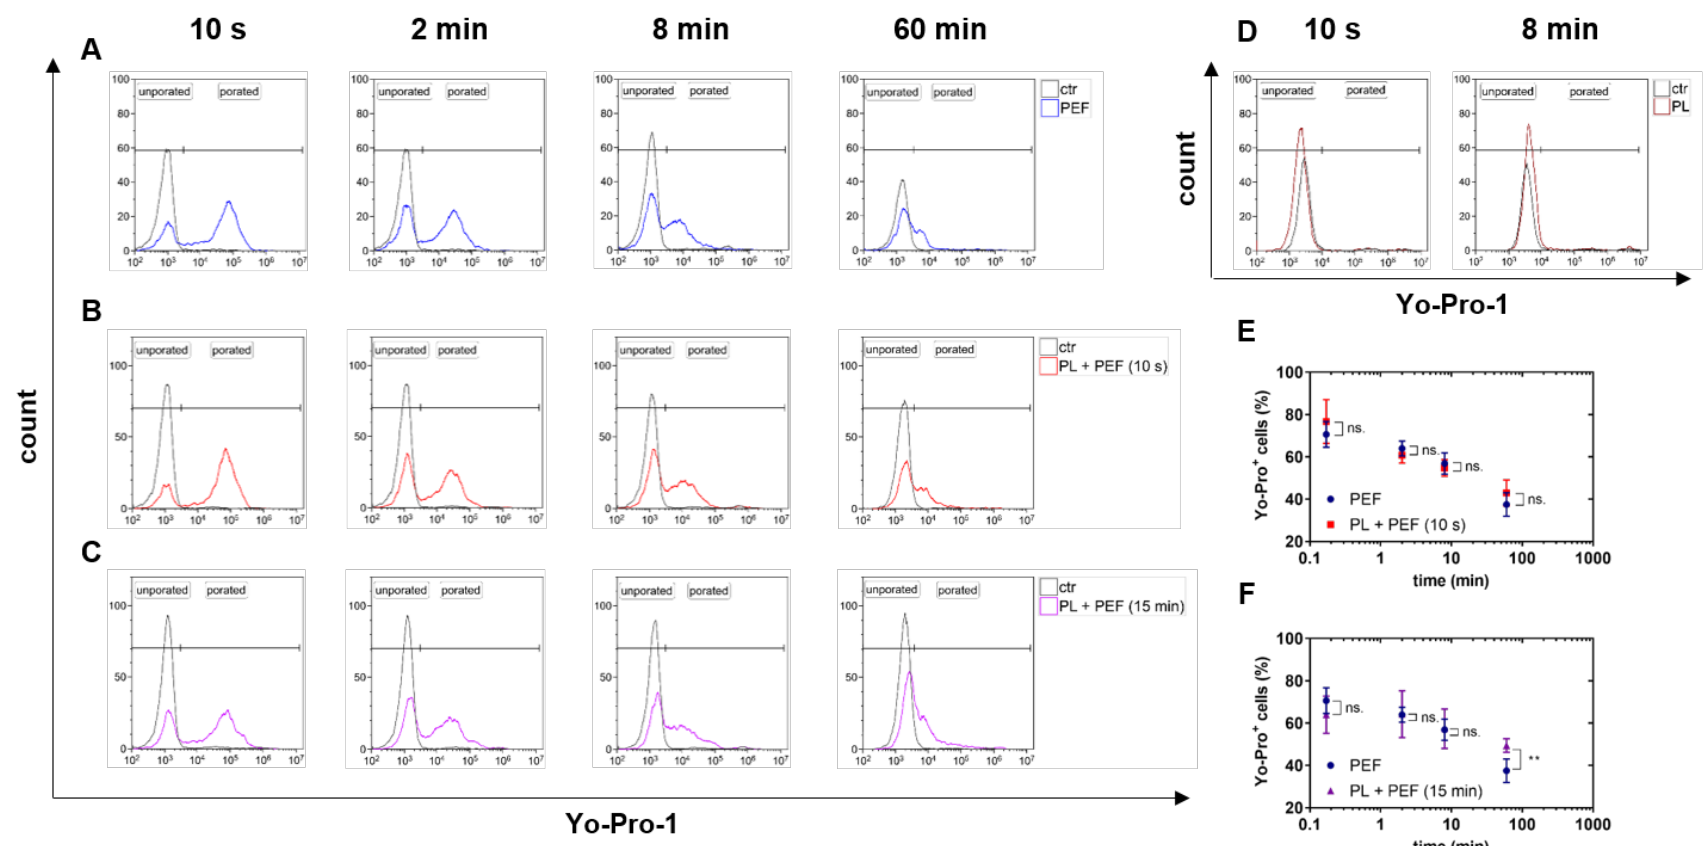
Figure 2. Electropermeabilization in PEF and plasma-treated lymphoma cells. The plasma exposure time was 90 s, and the electric field strength was 1 kV/cm. The electropermeabilization of cells was measured by the entry of Yo-Pro-1 10 s, 2 min, 8 min, and 60 min after the treatment using flow cytometry. The amount of electropermeabilized cells after PEF alone was administered ( A ) and was compared to cells pretreated with plasma 10 s before the PEF ( B ) or 15 min before the PEF ( C ). Plasma alone did not have any e ff ect on the permeabilization of the cell membrane ( D ). Significant di ff erences between the plasma-pretreated cells and the single PEF-treated cells were analyzed by t-test ( E , F ). Data are shown as one representative ( A – D ) or mean + S.E. ( E , F ) of at least four independent experiments. ctr = control; PL = plasma; PEF = pulsed electric fields; n.s. = not significant.